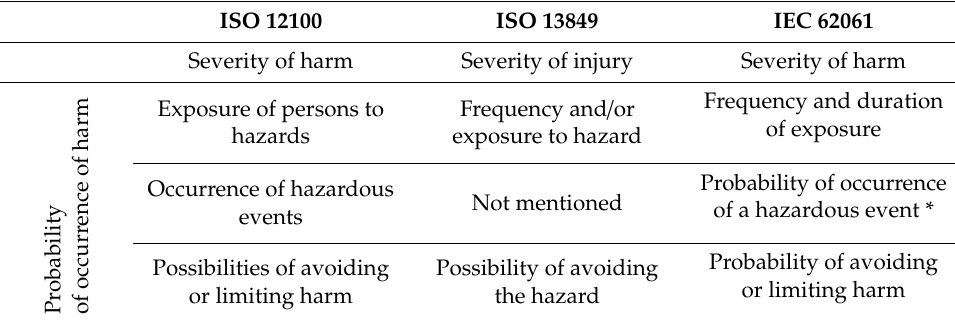
Table 2. Parameters used for risk estimation in three fundamental